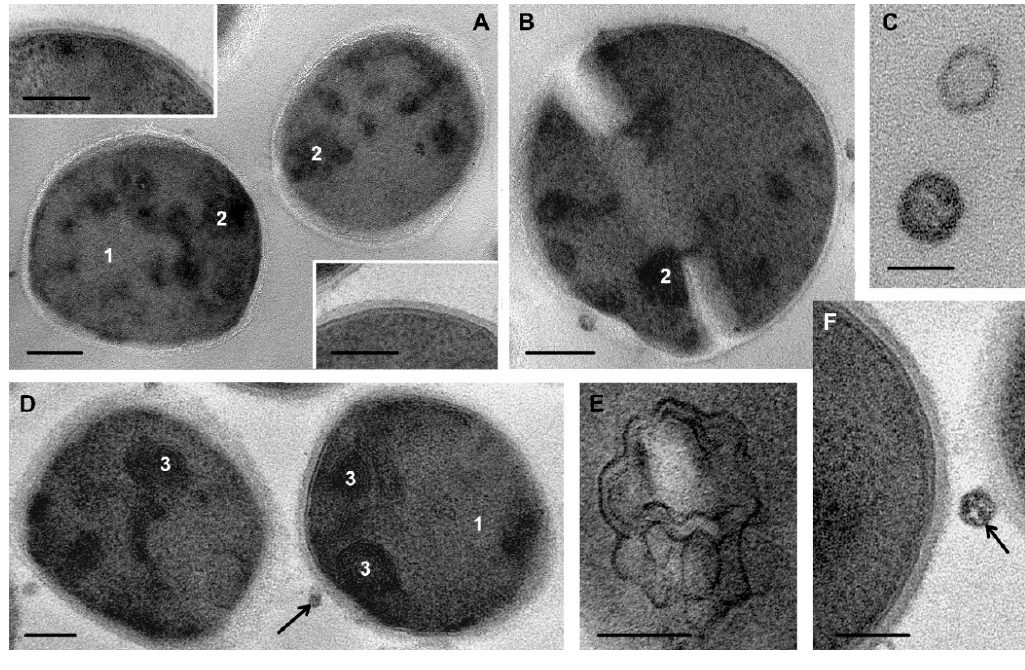
Figure 7. Cells of S. aureus incubated with chlorhexidine for 1 min ( A , B ) and 15 min ( D,F ). ( C )—membrane vesicles, 1 min oh incubation. ( E ) mesosome. 1—cytoplasm, 2—electron dense clumps, 3—electron dense masses. Extracellular vesicles are shown with arrows. TEM of ultrathin sections. Scale bars correspond to: ( A , B , D , F )—200 nm, ( C , E )—100 nm, insets—100 nm.